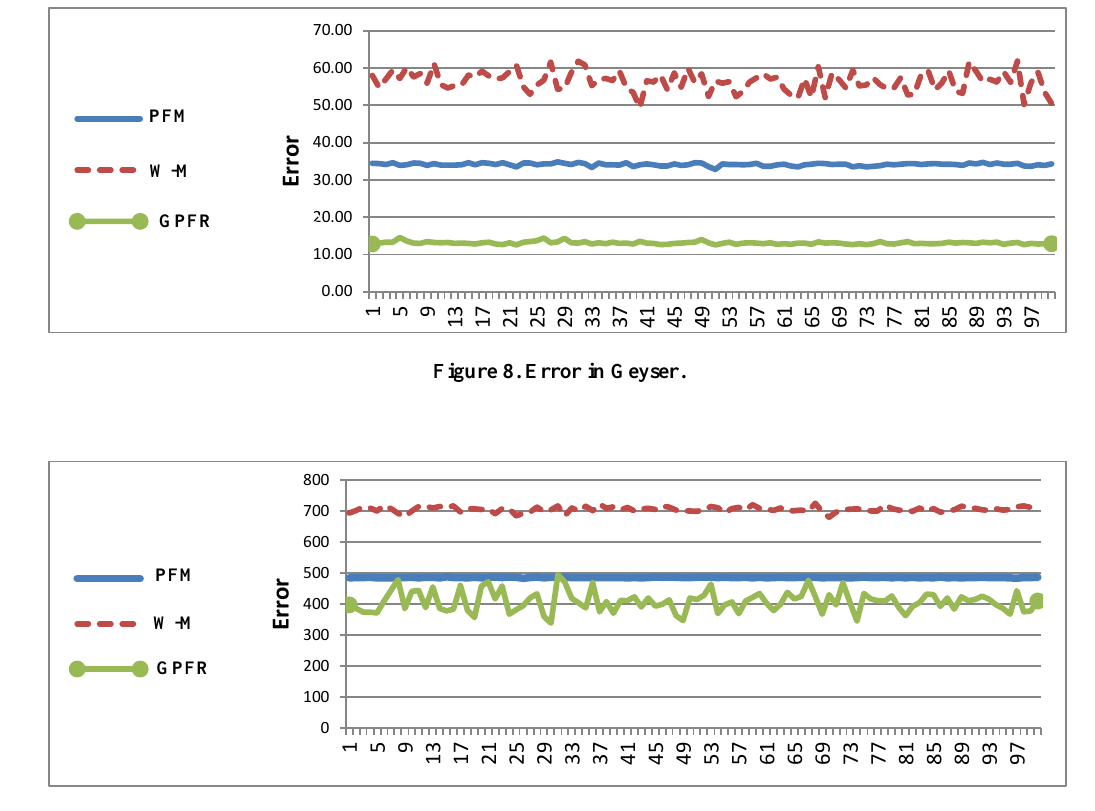
Figure 9. Error in E-puck Robot